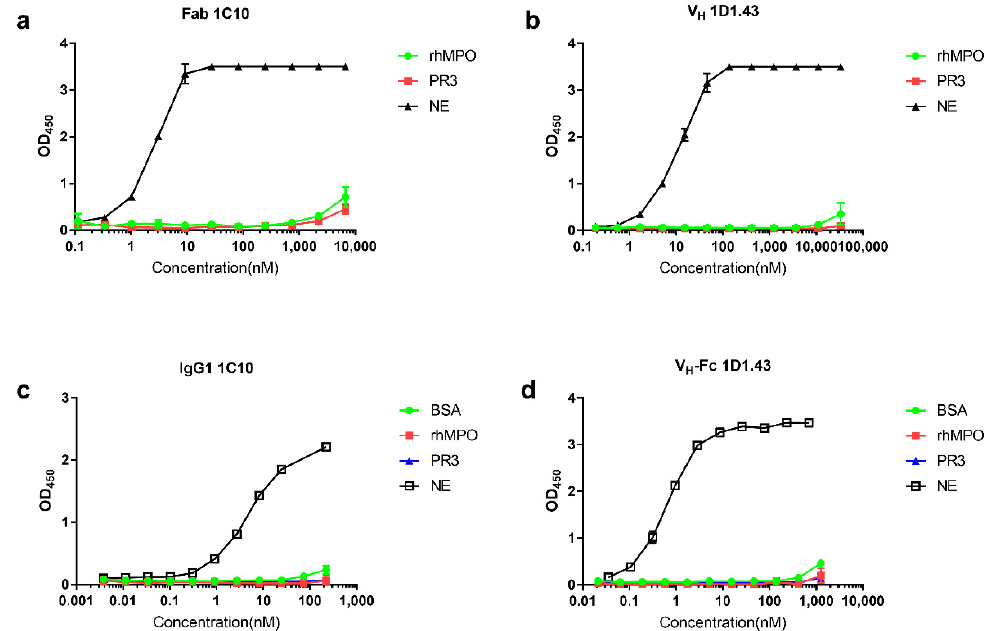
Figure 2. Specificity of V H /V H -Fc and Fab/IgG1 with recombinant human NE. ( a , b ) Binding of Fab 1C10 ( a ) and V H 1D1.43 ( b ) to rhNE, rhMPO, and PR3 measured by ELISA. ( c , d ) Binding of IgG1 1C10 ( c ) and V H -Fc 1D1.43 ( d ) to rhNE, rhMPO, BSA, and PR3 measured by ELISA. rhNE, rhMPO, BSA, and PR3 were coated in 96-well microplates at 50 ng/well. Experiments were performed in duplicate. Values were reported as the mean ± SD.